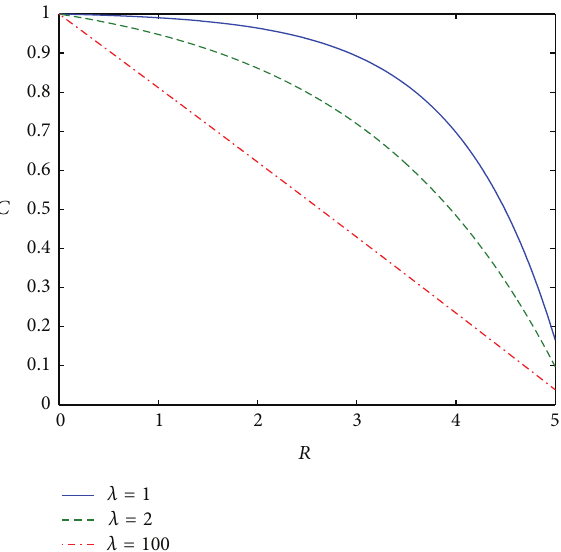
Figure 5: Steady contaminant profile for concentration given in (37). Here 𝜆 = 1 .